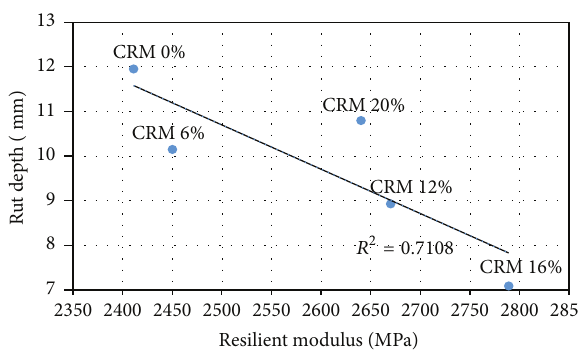
Figure 5: Rut depth versus resilient modulus (stiffness dynamic).